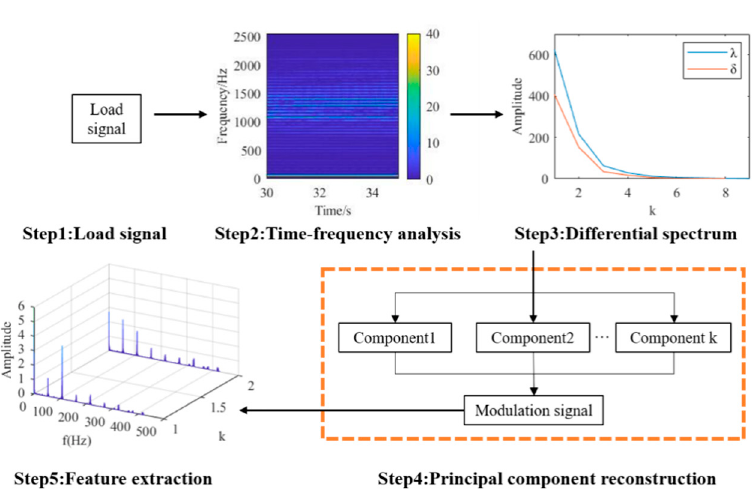
Figure 2. DPCA method principle schematic diagram.